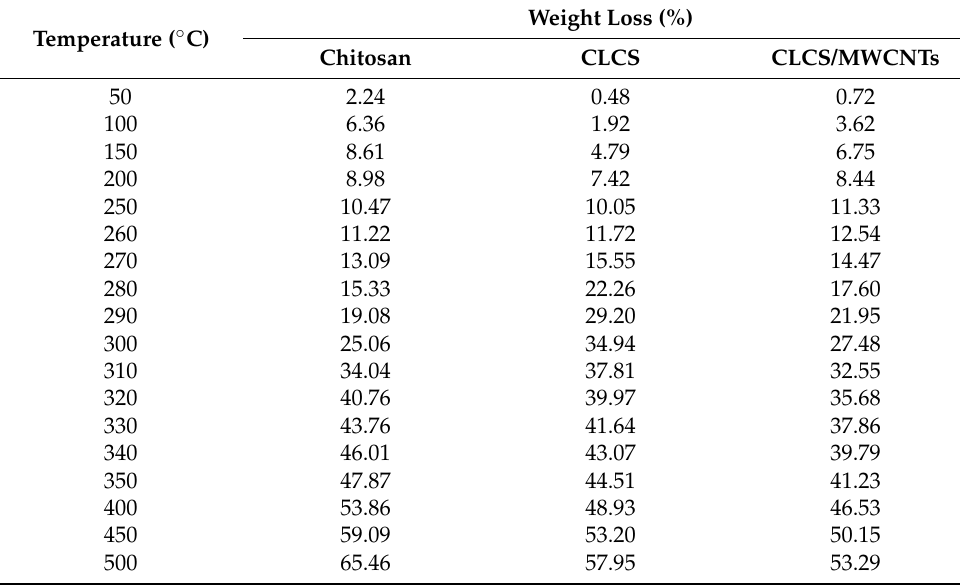
Figure 6. Typical TG thermograms of chitosan, CLCS and CLCS/MWCNTs composite. All the thermograms were recorded from room temperature to 500 ◦ C, at a heating rate of 10 ◦ C min − 1 and under an air flow rate of 30 mL min − 1 . Table 1. Thermogravimetric analysis results of chitosan, CLCS and CLCS/MWCNTs composite at 10 ◦ C min − 1 heating rate in air.